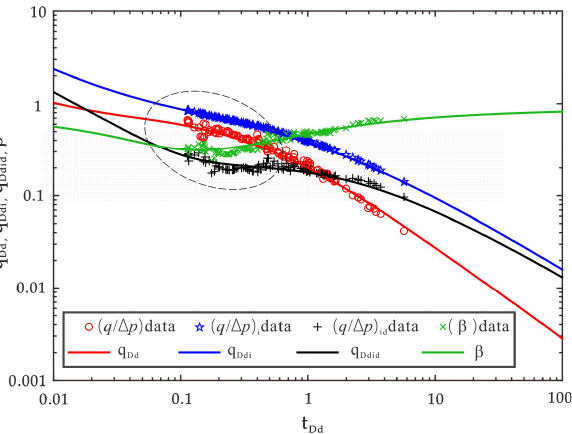
Figure 10. Application results of Blasingame curves based on the conventional SRV model .